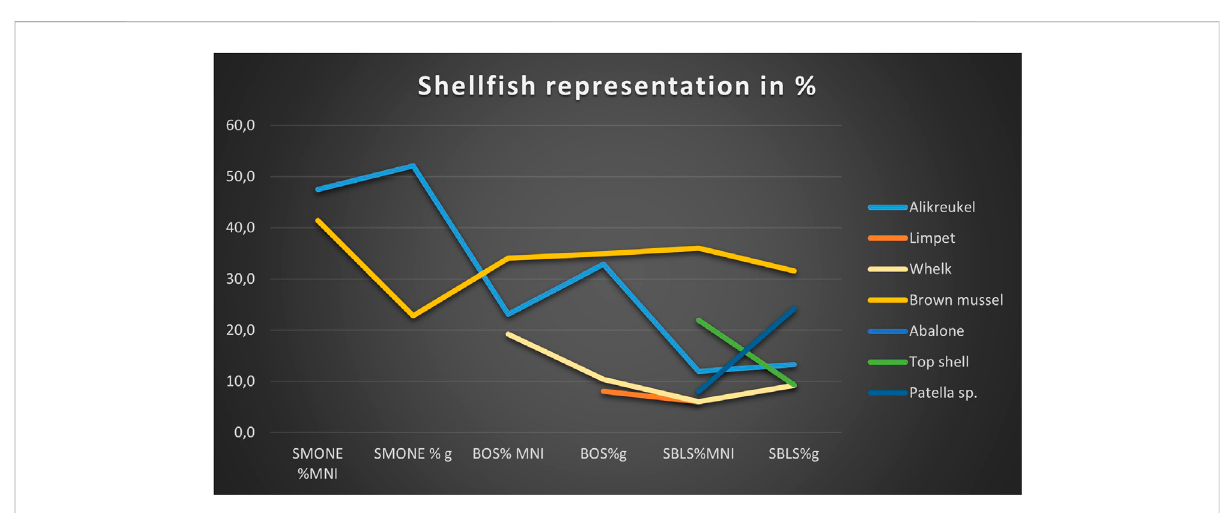
FIGURE 8 Shell fi sh representation SMONE-SBLS (top 85% – 91%) (see Table 3 for